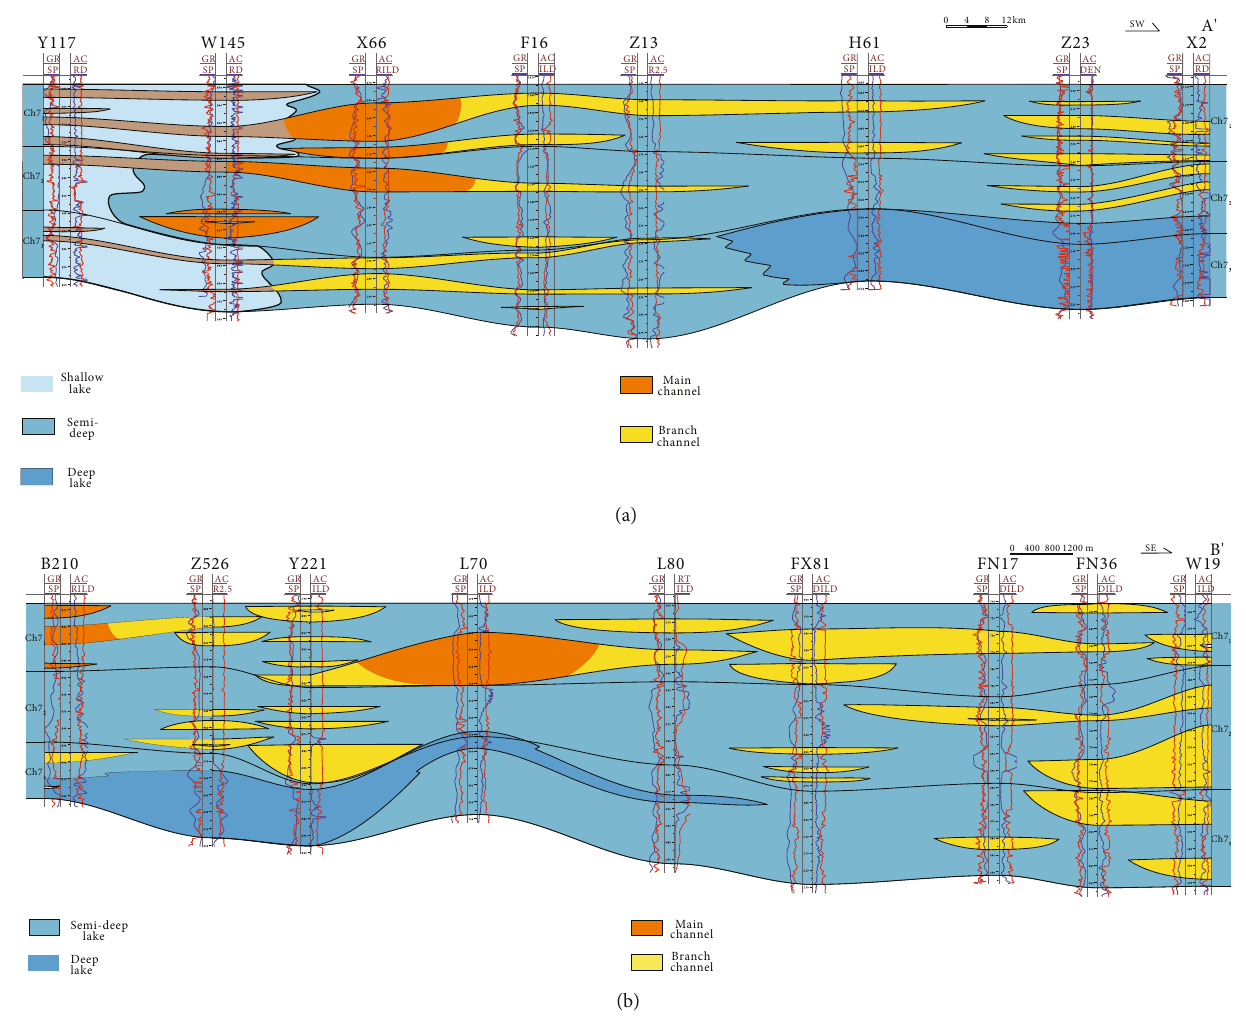
Figure 10: Cross section showing sedimentary facies distribution of Chang 7 interval in the study area (the section position is shown in Figure 1).